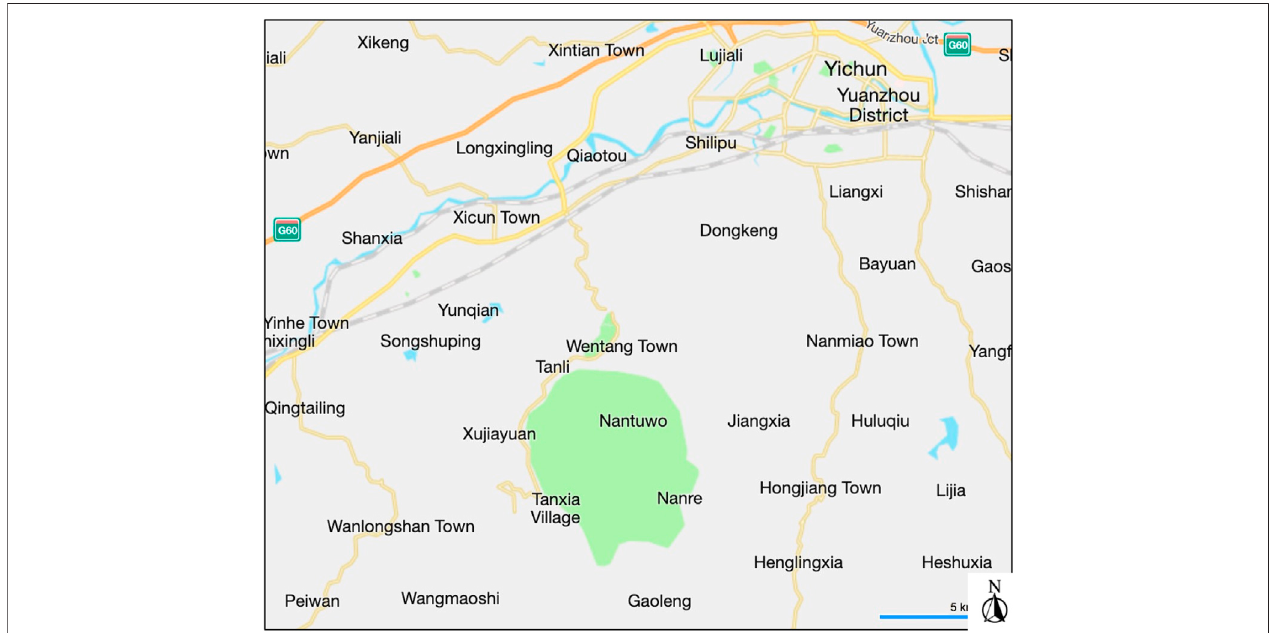
FIGURE 1 | The location of Wentang geothermal fi eld in Wentang Town, Jiangxi Province of China.